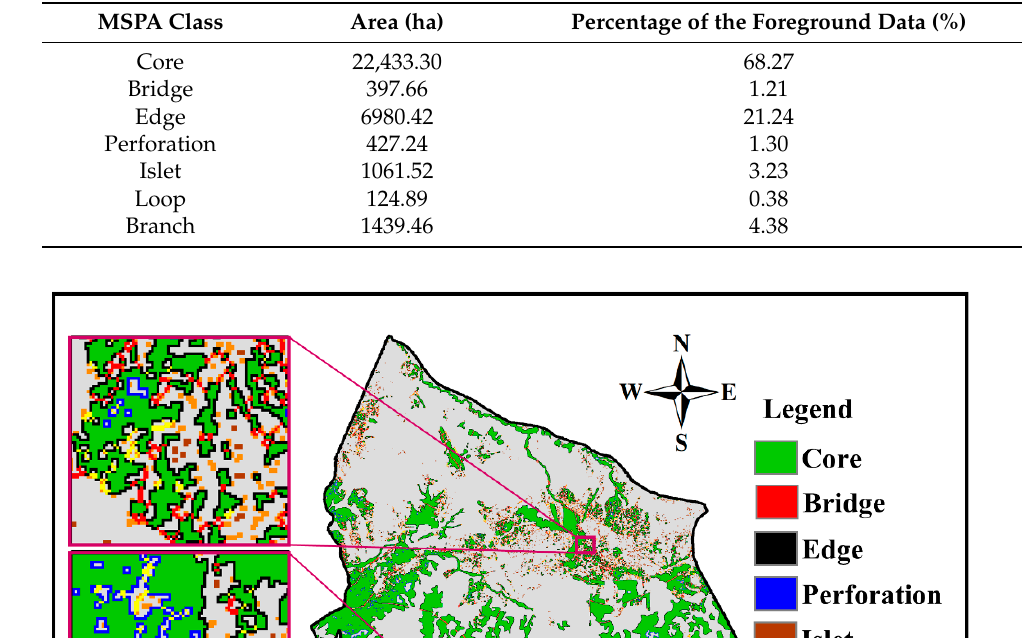
Table 5. Statistics of landscape type based on MSPA.